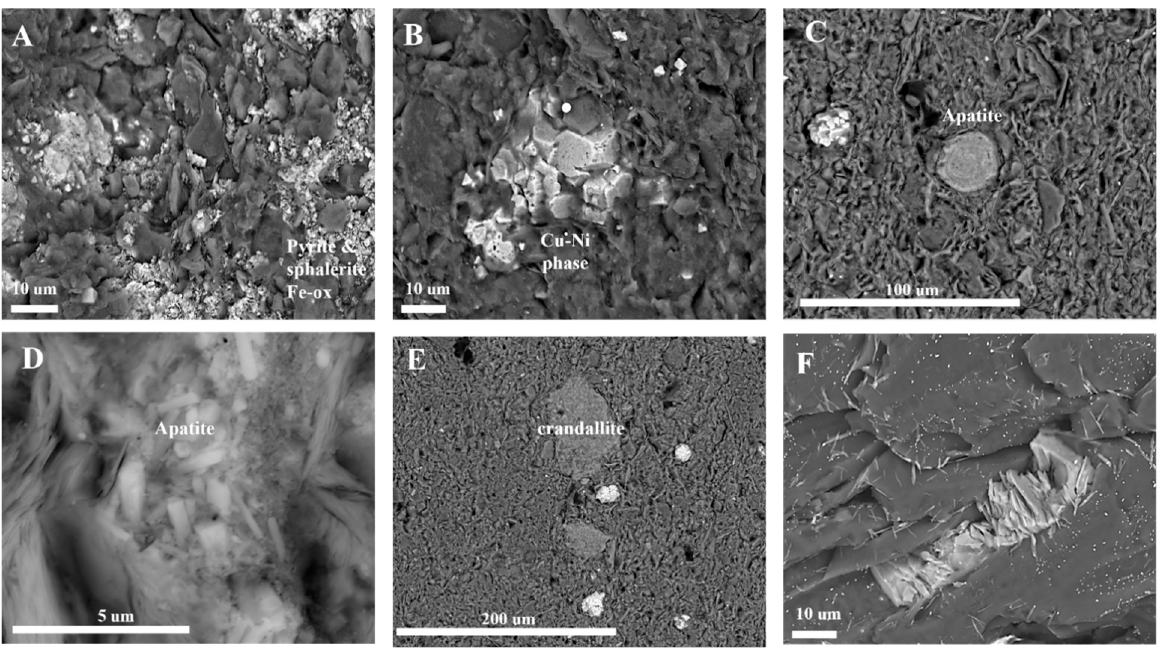
Figure 2. Electron images: ( A ) an agglomeration of pyrite, sphalerite, and Fe-oxyhydroxides within the clay matrix (WV MKT underclay); ( B ) Cu-Ni (+Fe) sulfate (WV MKT underclay); ( C , D ) crystalline and fibrous apatite (WV MKT underclay); ( E ) crandallite (WV MKT underclay); ( F ) clay matrix and nano-minerals (Central PA MKT underclay).